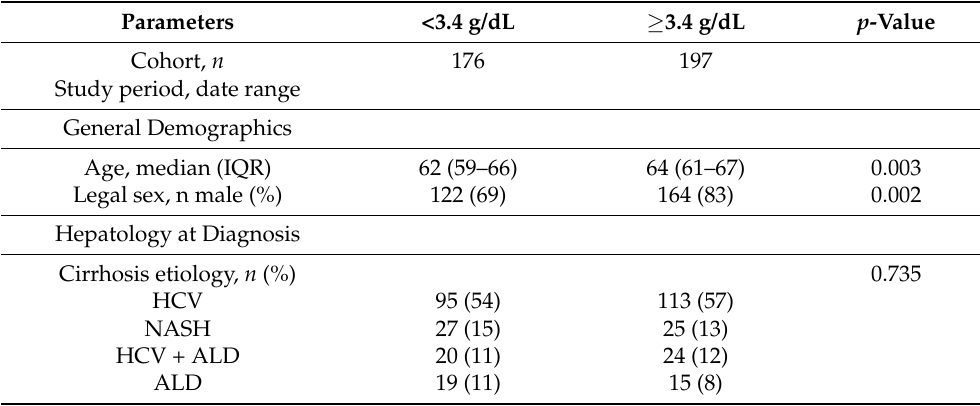
Table 5. Clinical parameters associated with albumin < 3.4